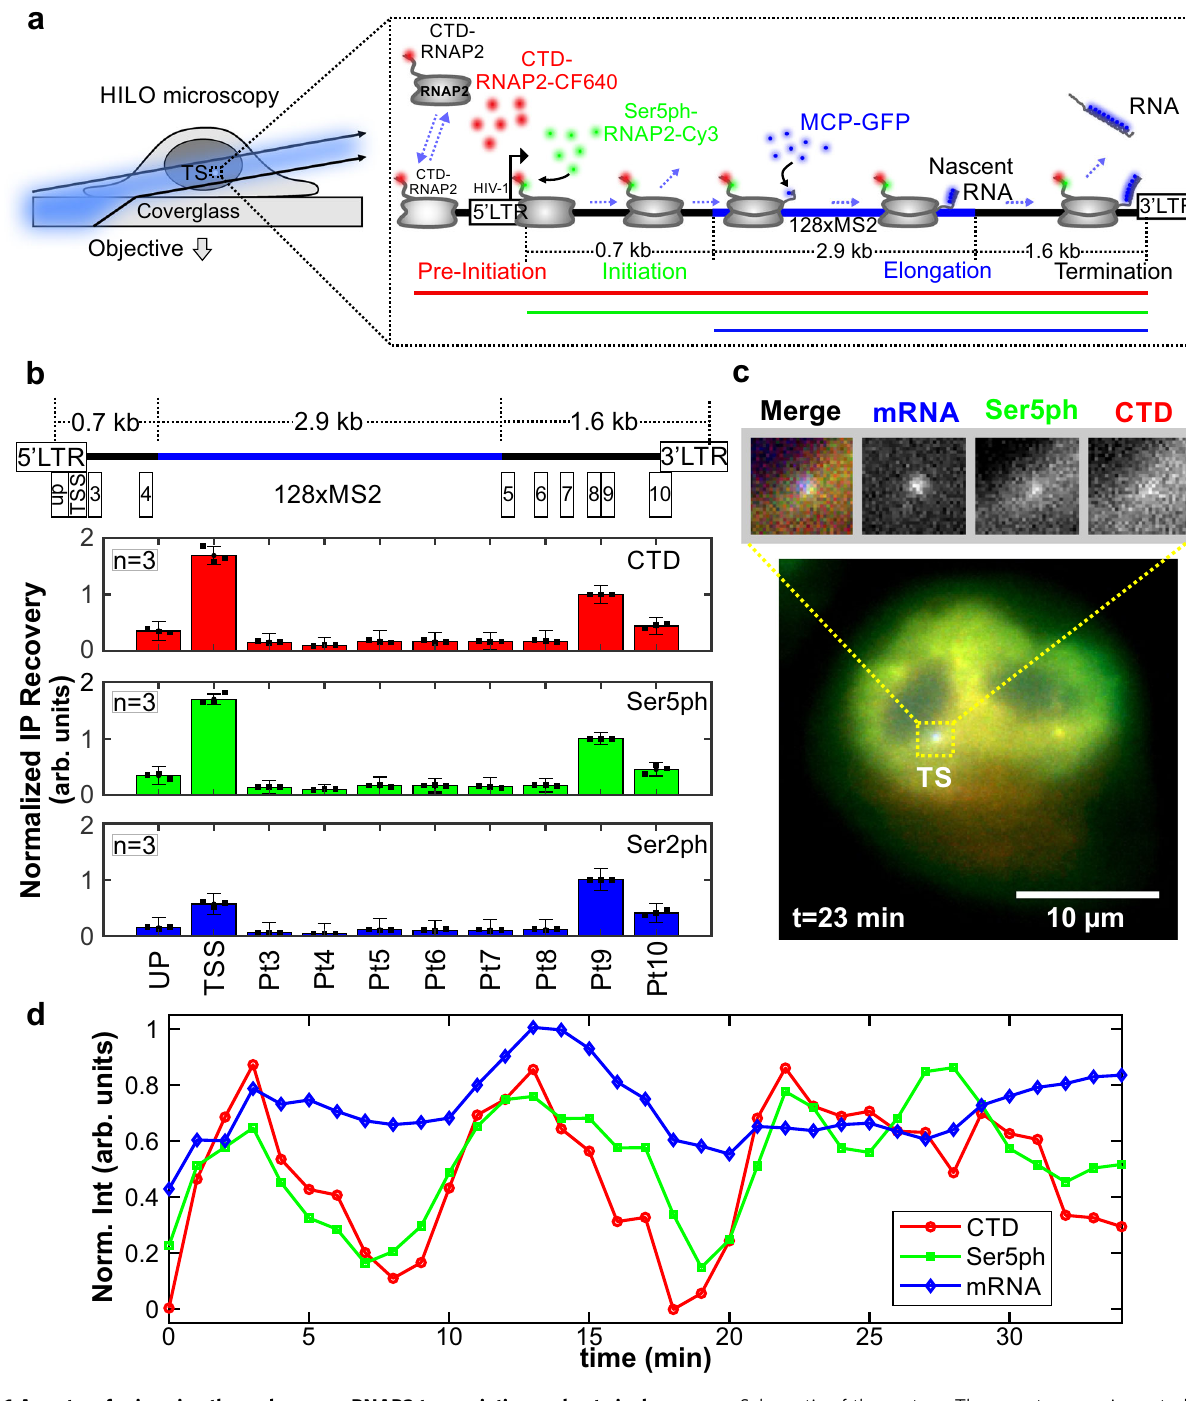
Fig. 1 A system for imaging the endogenous RNAP2 transcription cycle at single genes. a Schematic of the system. The reporter gene is controlled by the HIV-1 promoter and is tagged with a 128xMS2 cassette (blue bar). RNAP2 is represented in gray. RNA is marked by MCP-GFP that binds to the transcribed MS2 stem – loops (mRNA, blue). The recruited and initiated RNAP2 are labeled by Fabs (conjugated with CF640 and Cy3) that bind unphosphorylated and phosphorylated CTD RNAP2 heptad repeats (CTD, red) and Serine 5 phosphorylated repeats (Ser5ph, green), respectively. b Average chromatin immunoprecipitation occupancy of CTD-RNAP2 (red, upper panel), Ser5ph-RNAP2 (green, middle panel), and Ser2ph-RNAP2 (blue, lower panel) across the HIV-1 reporter gene (positions 1 – 10 are highlighted in the cartoon above). Data are presented as mean values ± S.E.M. c Sample live-cell showing CTD-RNAP2, Ser5ph-RNAP2, and mRNA co-localizing at the transcription site (TS), n = 9 cells in 4 independent experiments. d Normalized intensity at the TS over time from the cell in ( c ) for CTD-RNAP2 (red circles), Ser5ph-RNAP2 (green squares), and mRNA (blue